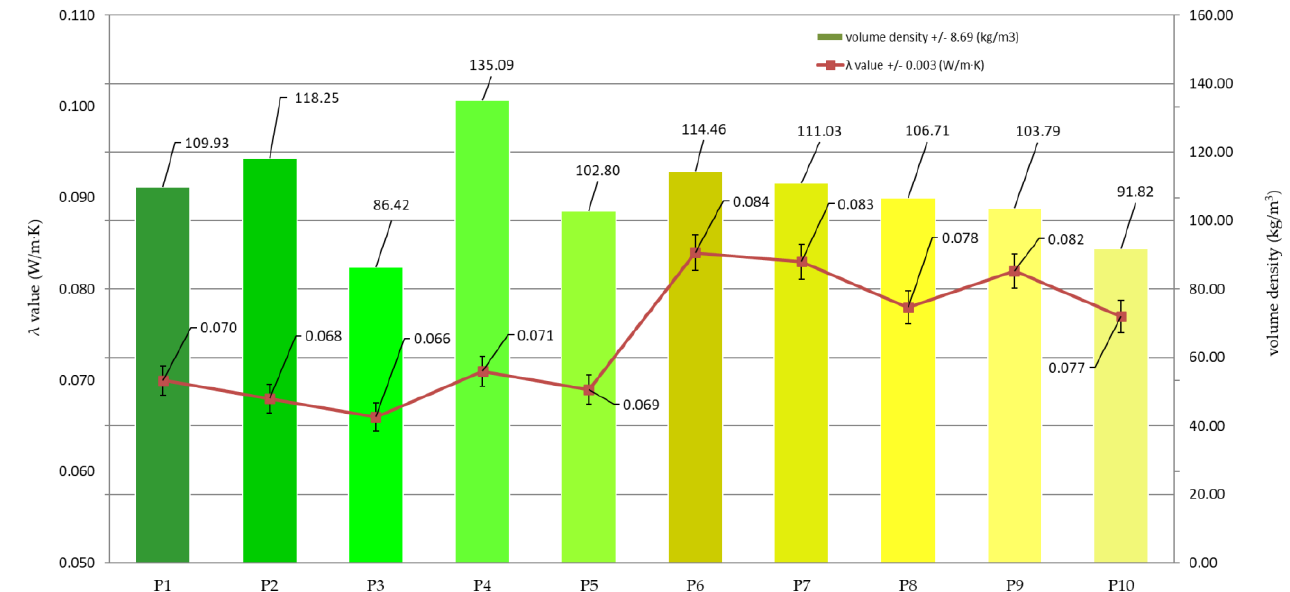
Figure 11. Relation between λ value and volume density of P1 ÷ P5 samples for heat flow across stems and P6 ÷ P10 for heat flow along the stems.